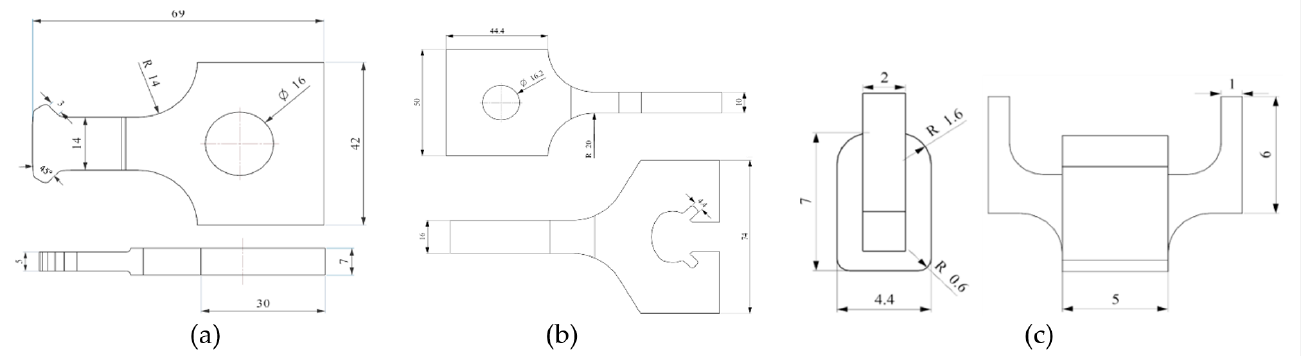
Figure 2. Dimensions of the specimen. ( a ) Dovetail specimen; ( b ) clamp; ( c ) fretting pad specimen. (Unit: mm).